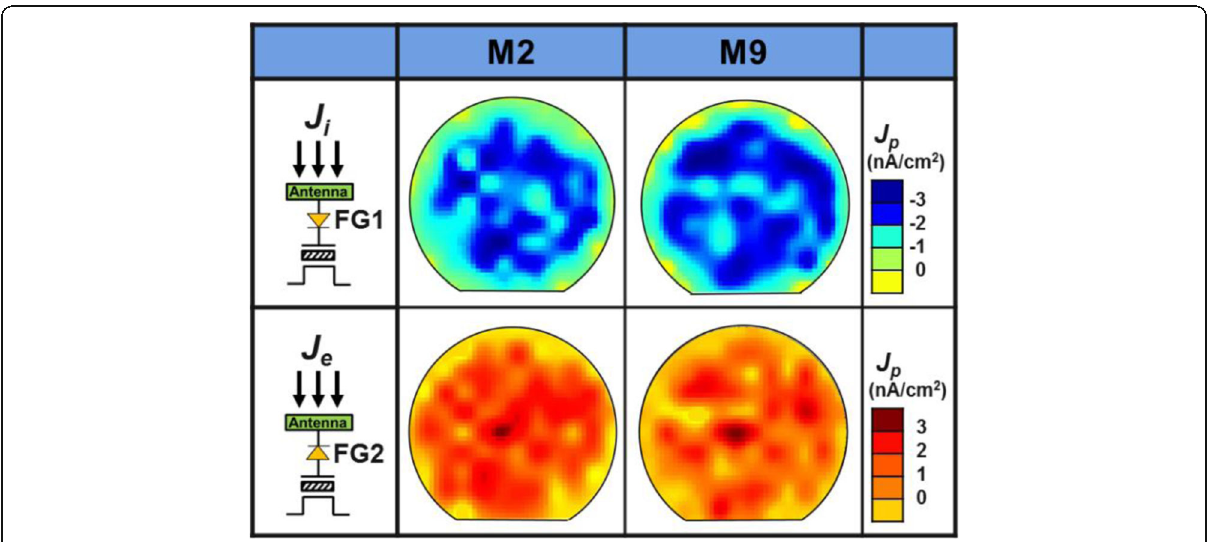
Fig. 9 The projected electron and ion charging rate, J e ( x , y ) and J i ( x , y ) are obtained by the charge splitting recorders across the etching surface during metal 2 metal 9 formation